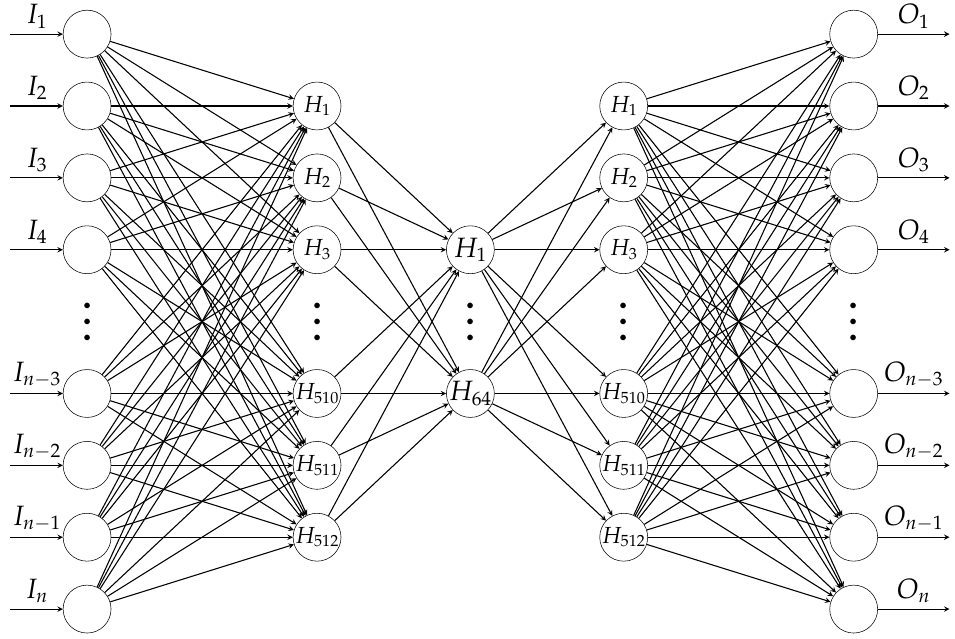
Figure 5. The architecture of the autoencoder of bottleneck type, where n denotes the dimensions: 19,560 for PFA and 15,648 for